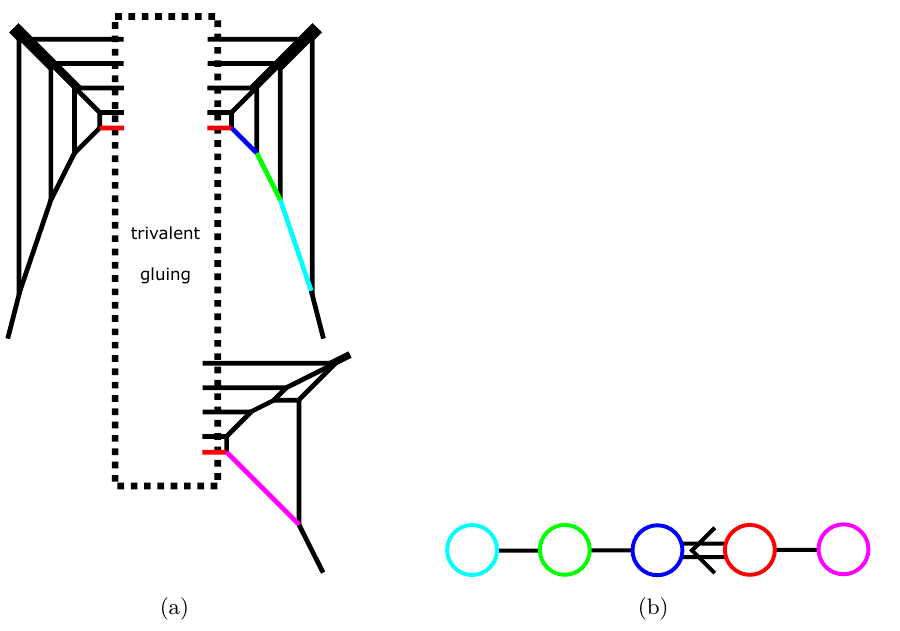
which is formed by the colored lines in fig- 6